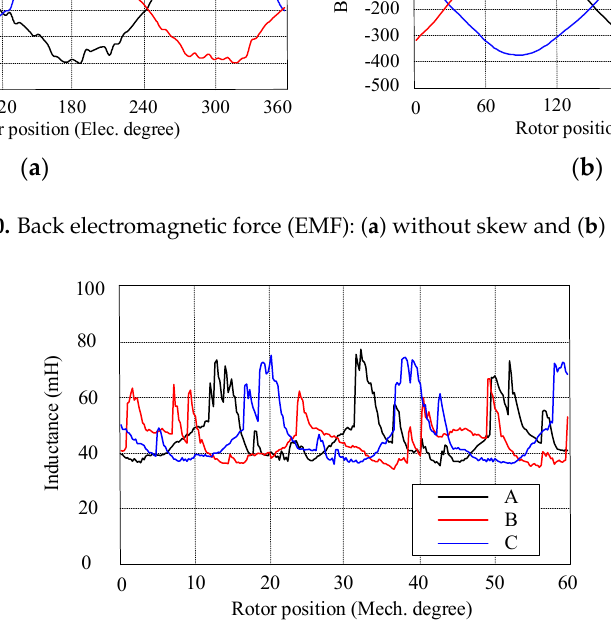
Figure 11. Variation of armature-winding inductance.